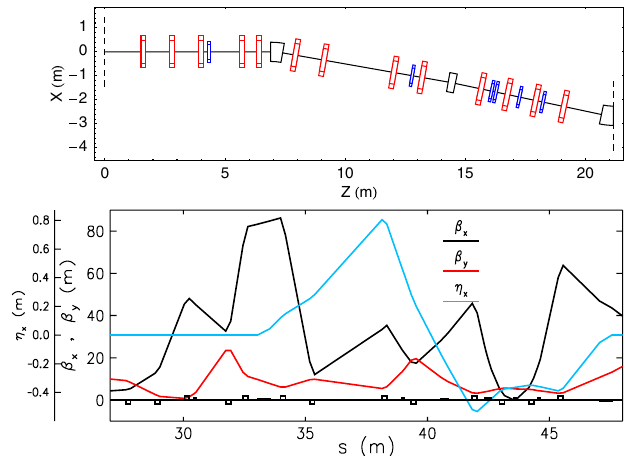
FIG. 2. Top: Floor layout of the injection achromat, sextupoles shown in blue. Bottom: Optics and dispersion functions in injection